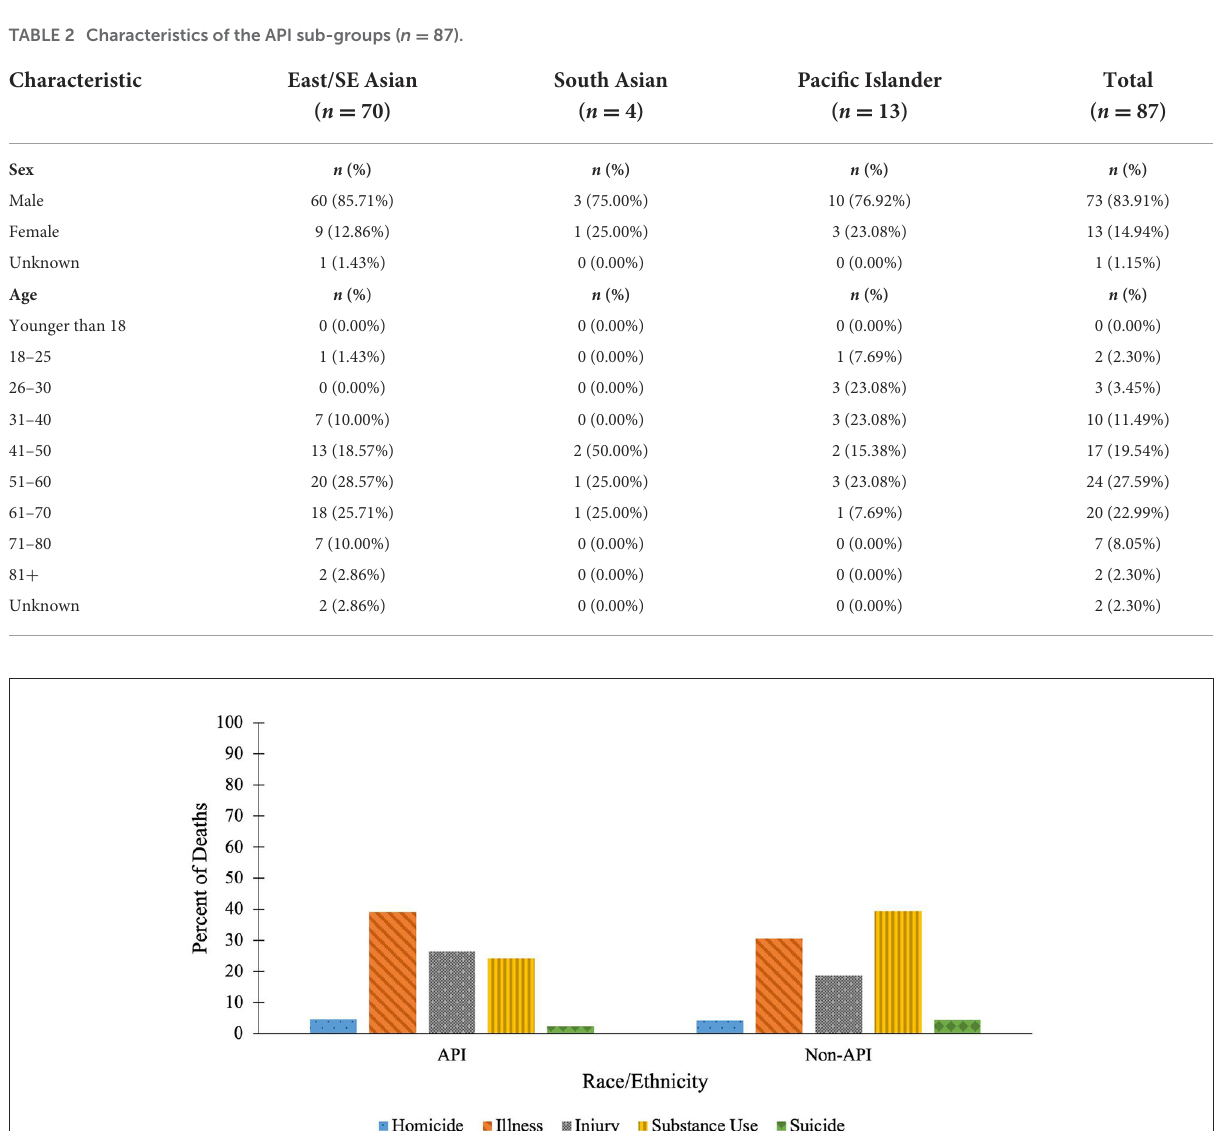
Cause of death by API sub-groups Due to small sample sizes, differences in causes of death between API sub-groups are not statistically